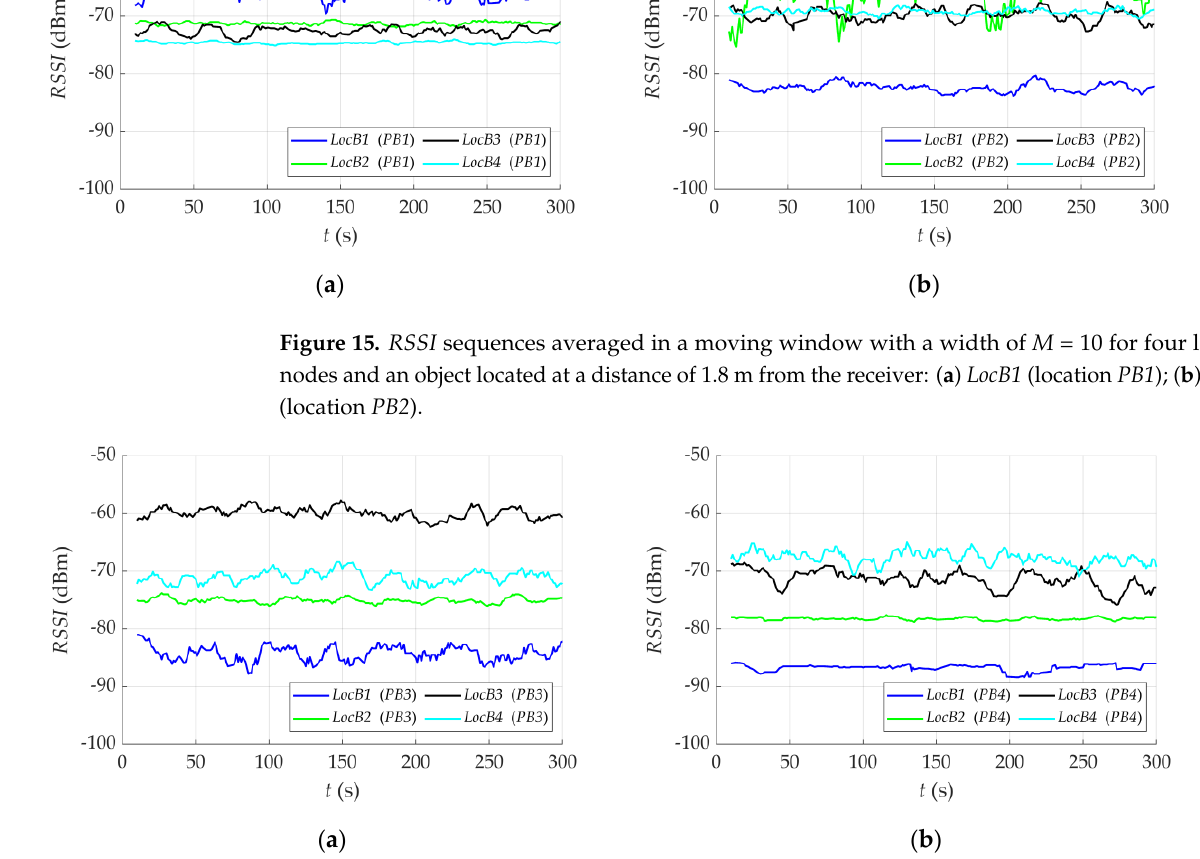
Figure 16. RSSI sequences averaged in a moving window with a width of M = 10 for four locator nodes and an object located at a distance of 1.8 m from the receiver: ( a ) LocB3 (location PB3 ); ( b ) LocB4 (location PB4 ).